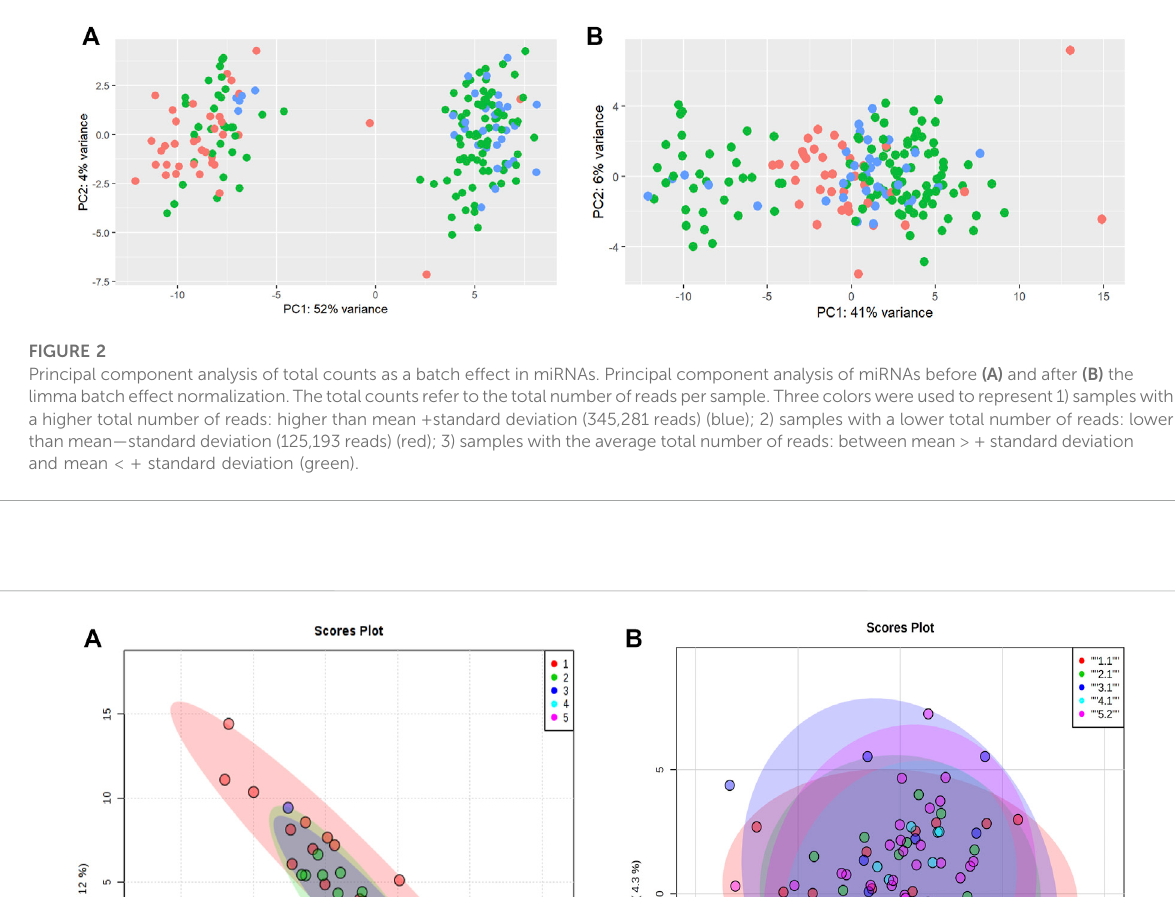
miRNA, and protein data were composed of fi ve, ten, and eight latent variables, respectively. Each omic dataset was assigned to a factor according to the highest loading value ( > |0.5|), fi ltering some latent variables composed of a few features. The fi nal underlying latent structures from EFA of the phenotype, miRNA, and protein data are shown in Figures 4, 5.